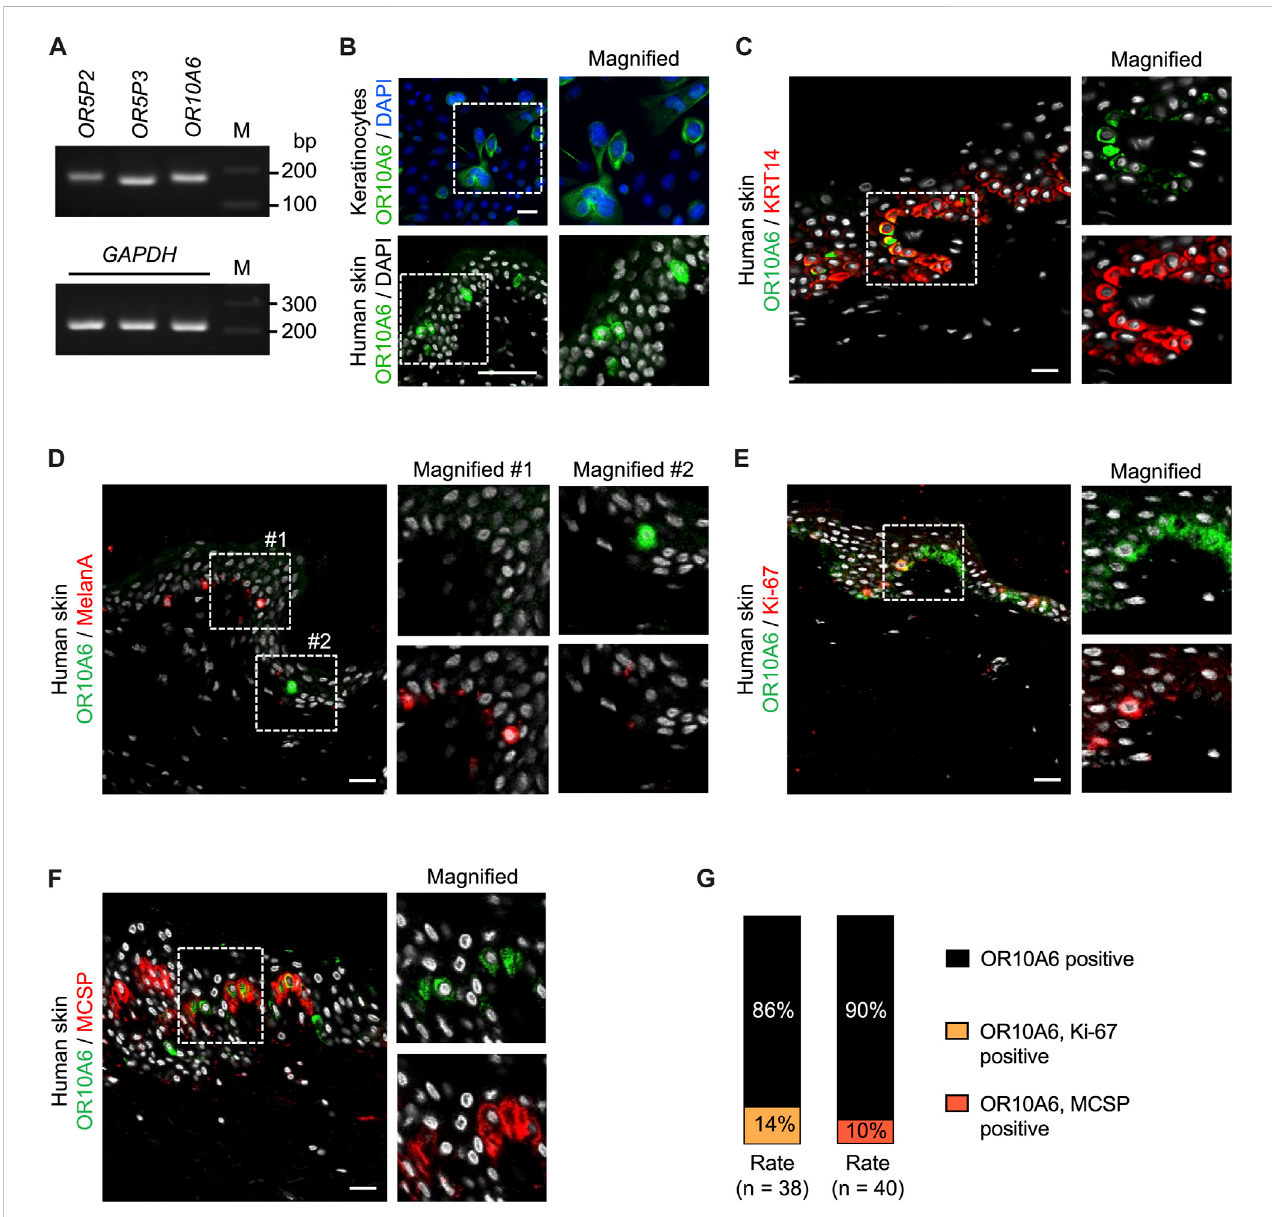
FIGURE 3 Expression of ORs in human keratinocytes and skin. (A) RT-PCR analysis of OR5P2 , OR5P3 , and OR10A6 . GAPDH was used for RNA quality control. M: Marker. (B) Immuno fl uorescence staining of OR10A6 (green) in human keratinocytes and skin. Cell nuclei appear in blue or white. Magni fi ed sections are indicated by white dashed squares. Bar = 50 μ m. (C – F) Immuno fl uorescence staining of OR10A6 (green) and KRT14, Melan A, Ki-67 or MCSP (red) in human skin. Cell nuclei appear in white. Magni fi ed sections are shown in white dashed squares. Bar = 20 μ m. (G) Ratio of OR10A6-positive cells, OR10A6 + Ki- 67-positive cells and OR10A6 + MCSP-positive cells counted in skin